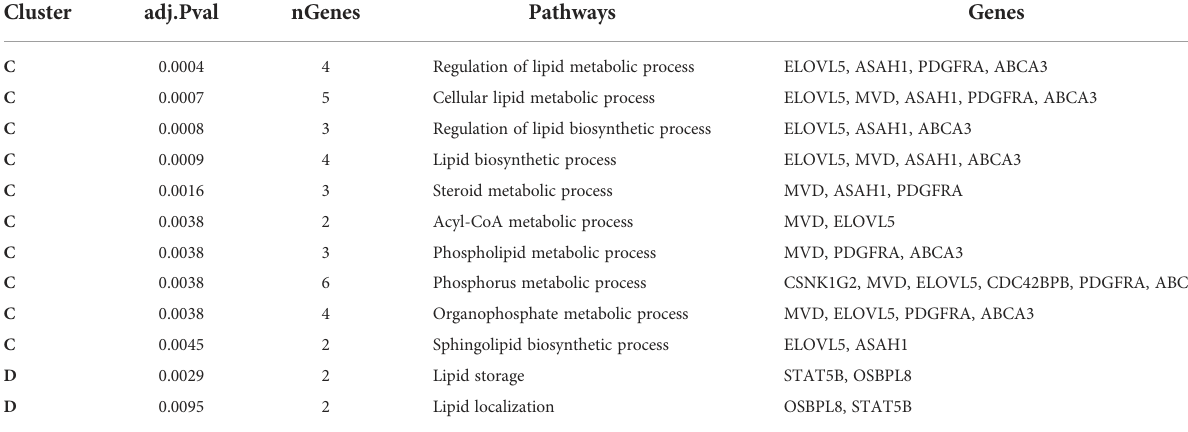
TABLE 3 iDEP Gene Enrichment Pathways for K-means